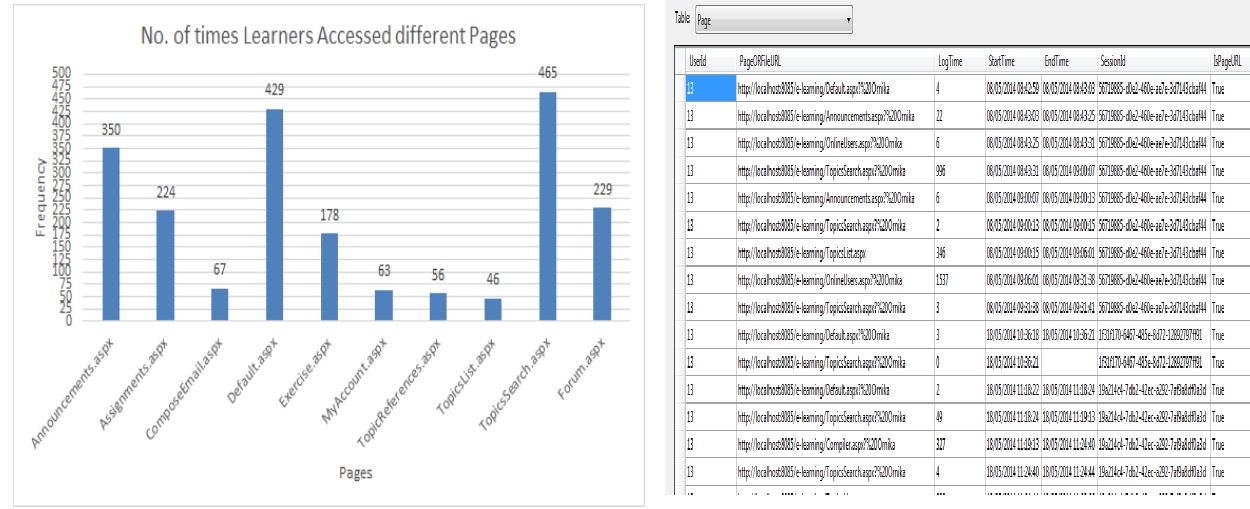
Figure 5. Analysis of Number of Times Learners Accessed